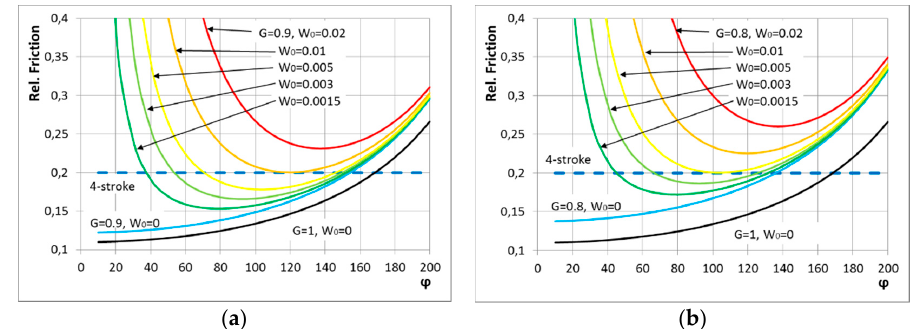
Figure 4. Relative mechanical losses F at ( a ) G = 0.9 and ( b ) G = 0.8. The referential pumping work W 0 and the scavenging e ffi ciency G largely determine a potential advantage or disadvantage with respect to a